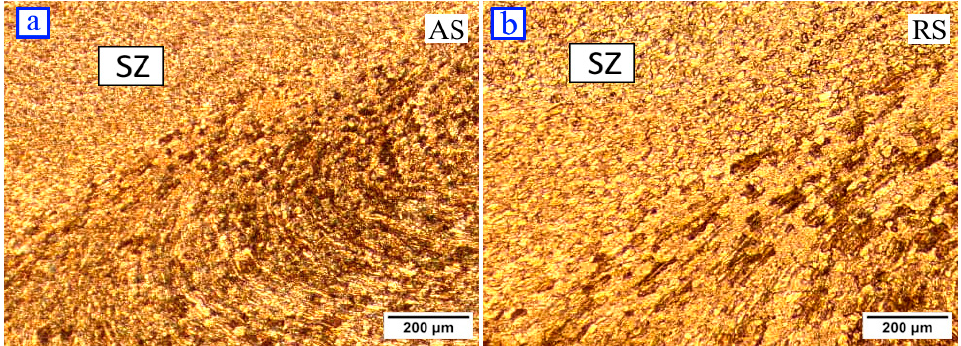
Figure 5. Optical micrographs of the weld after FSP: ( a ) advancing side and ( b ) retreating side.